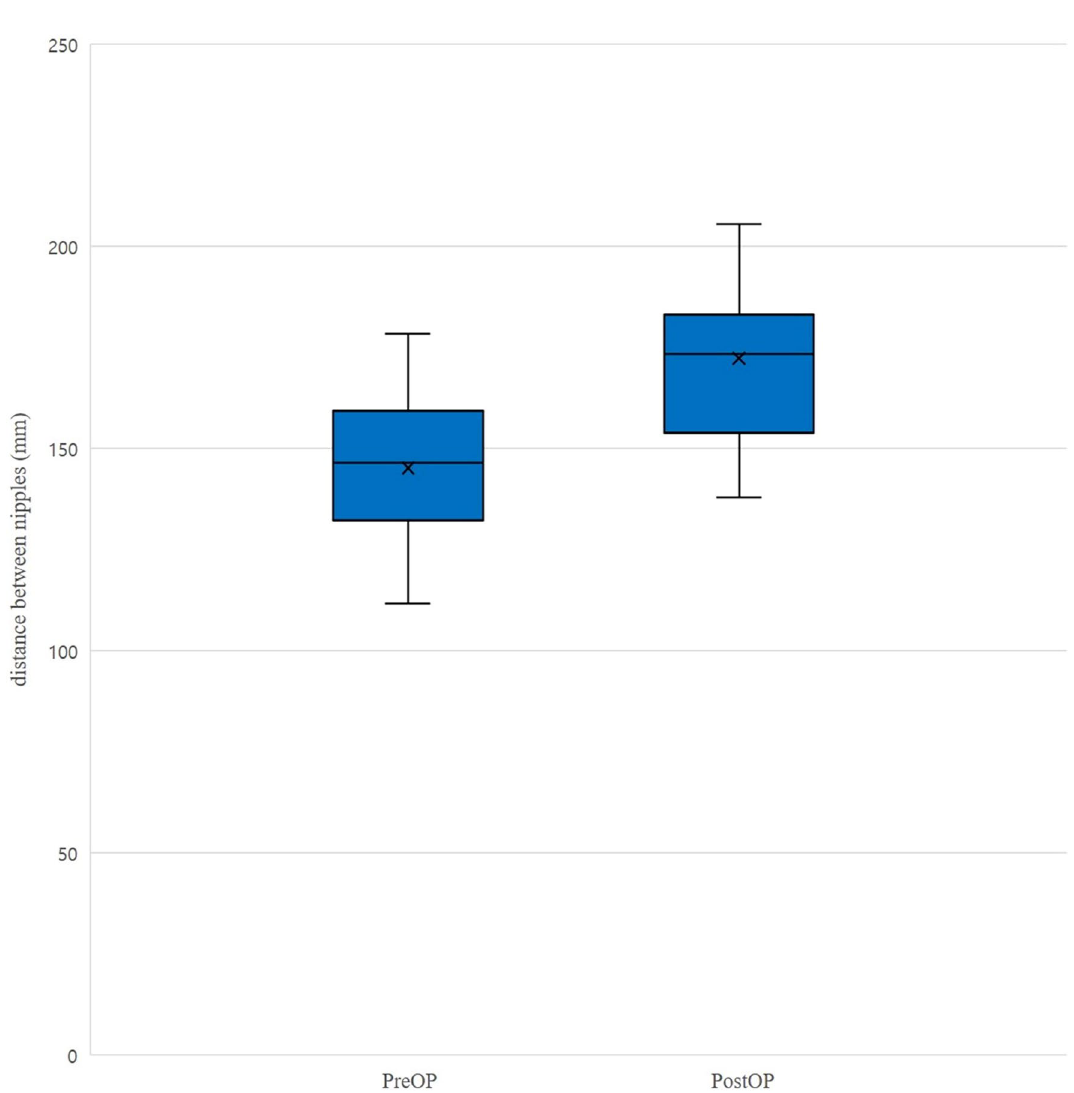
Figure 1. Box plot of the distance between nipples before and after modified Nuss procedures. Horizontal line indicates the median, box the interquartile range (IQR), whiskers extend to upper adjacent value (large value = 75th percentile + 1.5 × IQR) and lower adjacent value (smallest value = 25th percentile—1.5 × IQR), and ‘x’ in box represents the